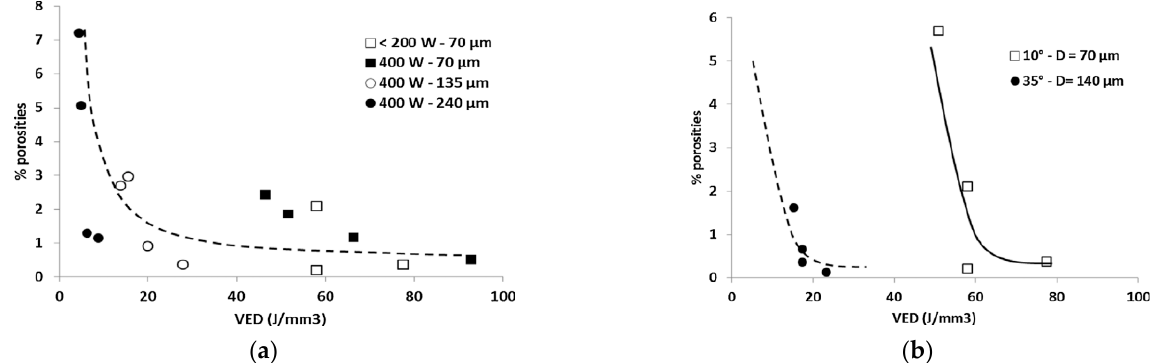
Figure 6. Dependence of porosity content versus process parameters in In625 for ( a ). P < 200 W and P = 400 W (10°), ( b ). Two distinct building angles (10° and 35°) (Adapted from [8] with permission, License number 5462380625001).